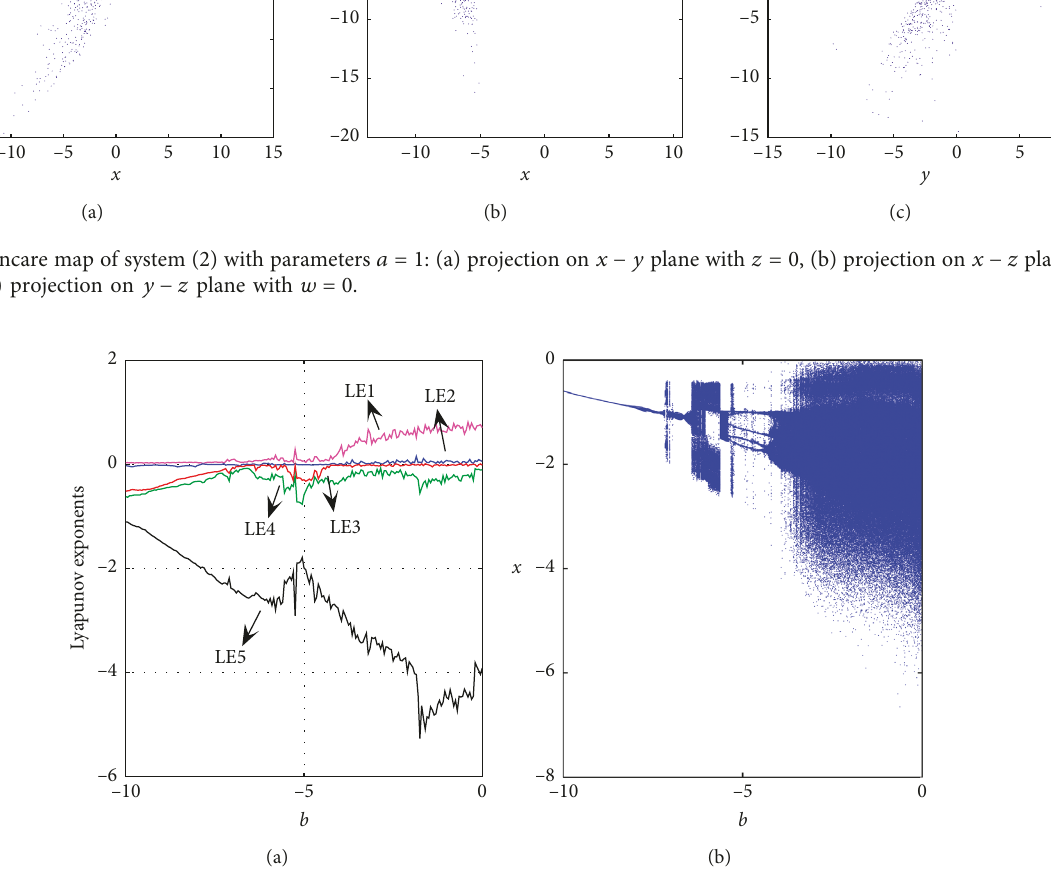
Figure 6: Lyapunov exponents and bifurcation diagram for increasing parameter b